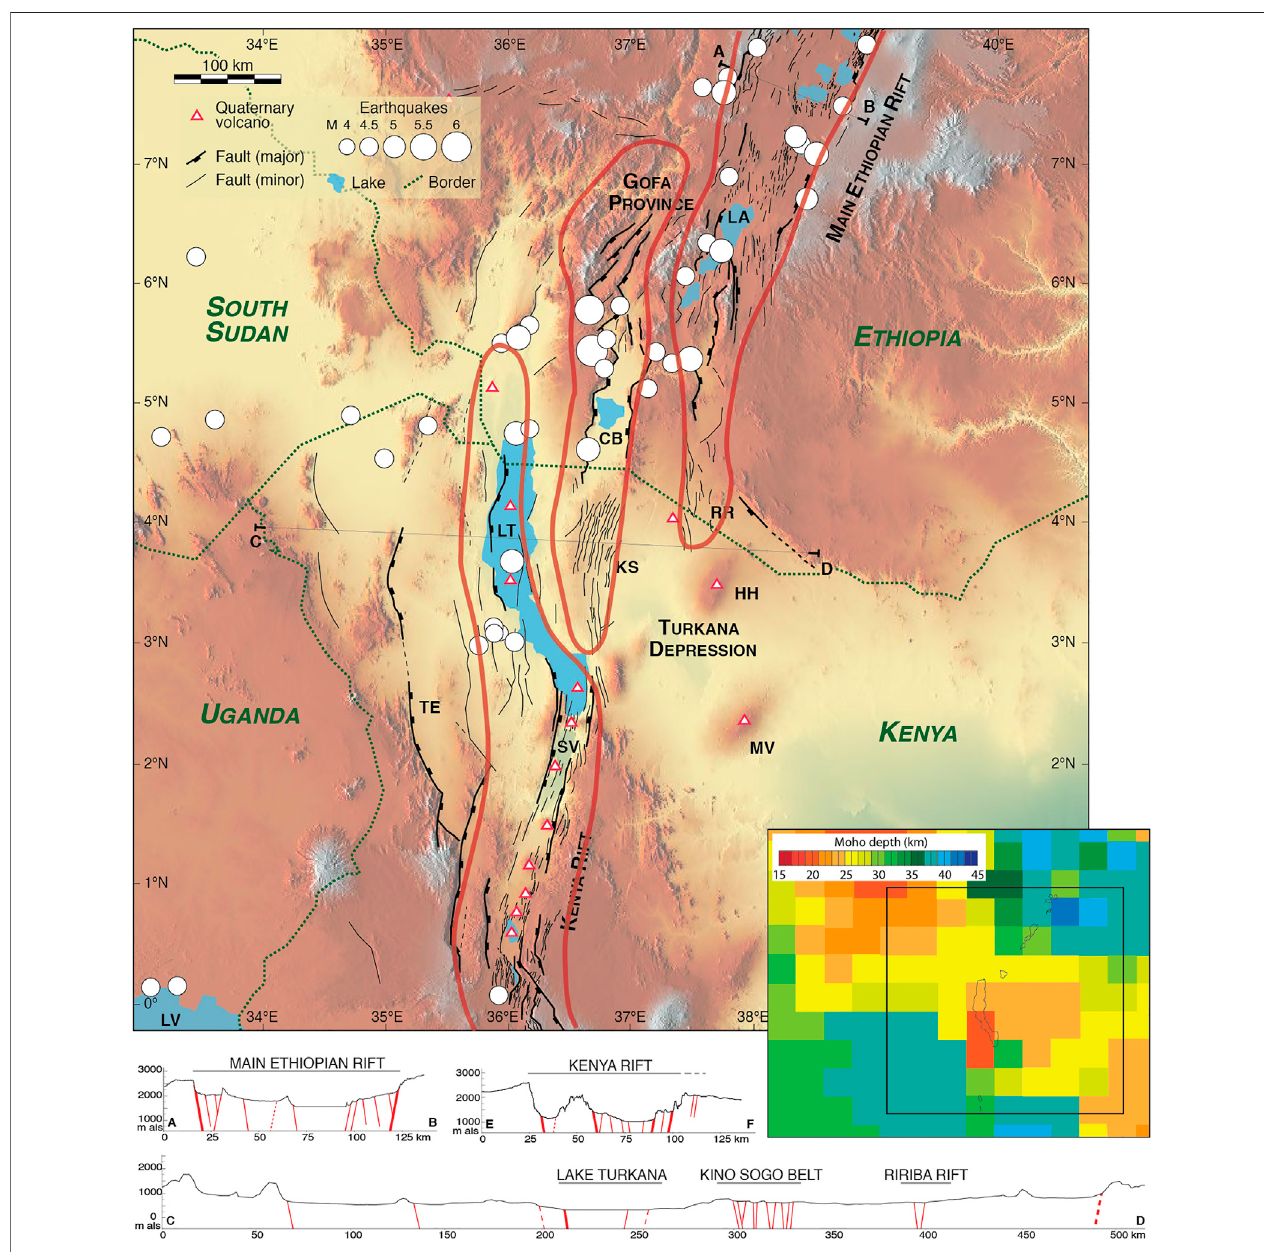
FIGURE 4 | Tectonic setting of the Turkana depression and surrounding regions, with Quaternary faults, seismicity and Quaternary volcanoes superimposed on a SRTM (Nasa Shuttle Radar Topography Mission, 30 m resolution) digital elevation model (modi fi ed from Brune et al., 2017). CB: Chew Bahir basin; HH: Hurri Hills; KS: KinoSogobelt;LA:LakeAbaya;LT:LakeTurkana;LV:LakeVictoria;MV:Marsabitvolcano;RR:RiribaRift;SV:SugutaValley;TE:TurkwellEscarpment.Areasencircled by red lines are the main deformation domains. Inset in the bottom right shows the crustal thickness in the region (from Benoit et al., 2006). Also illustrated are simpli fi ed cross sections highlighting the different architecture and distribution of deformation in the Turkana depression with respect to the Kenyan and Ethiopian rifts.